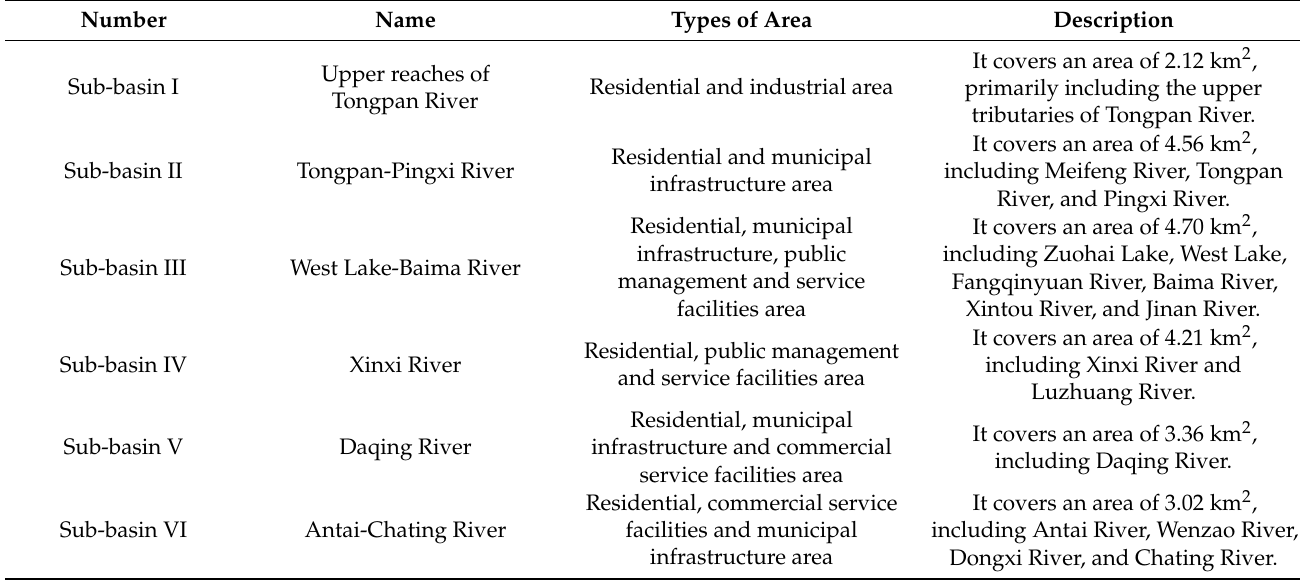
Table 2. General characteristics of selected six sub-basins in